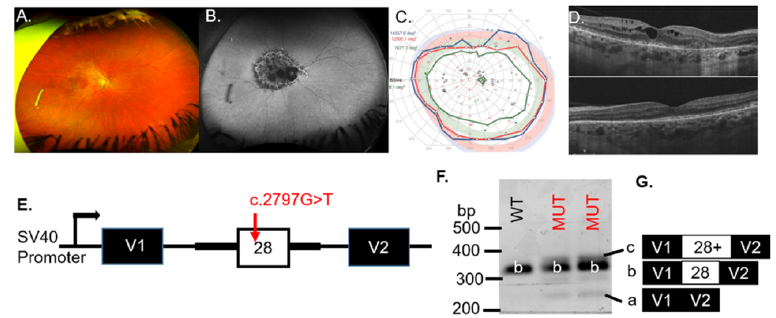
Figure 1. Analysis of OPA1 VUS c.2797G > T in a patient with ( A ) RPE and degenerative changes, arteriole narrowing, and ( B ) hypo-AF in the macula and around the optic nerve head, illustrated in the right-eye images. ( C ) The visual field of the right eye was full with minor decreased detection of the IVe stimulus (green line) and an enlarged scotoma (green with underlay) at the area corresponding to the peripapillary atrophy ( B ). ( D ) The right (top) eye showed cystoid macular edema on SD-OCT. ( E ) Schematic illustrations of the pSPL3-OPA1 minigene. The OPA1 exon 28, with wild-type (WT) or mutant (MUT) alleles, was cloned between vector exons (V1 and V2). ( F ) Representative gel electrophoresis of RT-PCR products from transfected COS-7 cells. ( G ) WT and MUT transcript content, determined by Sanger